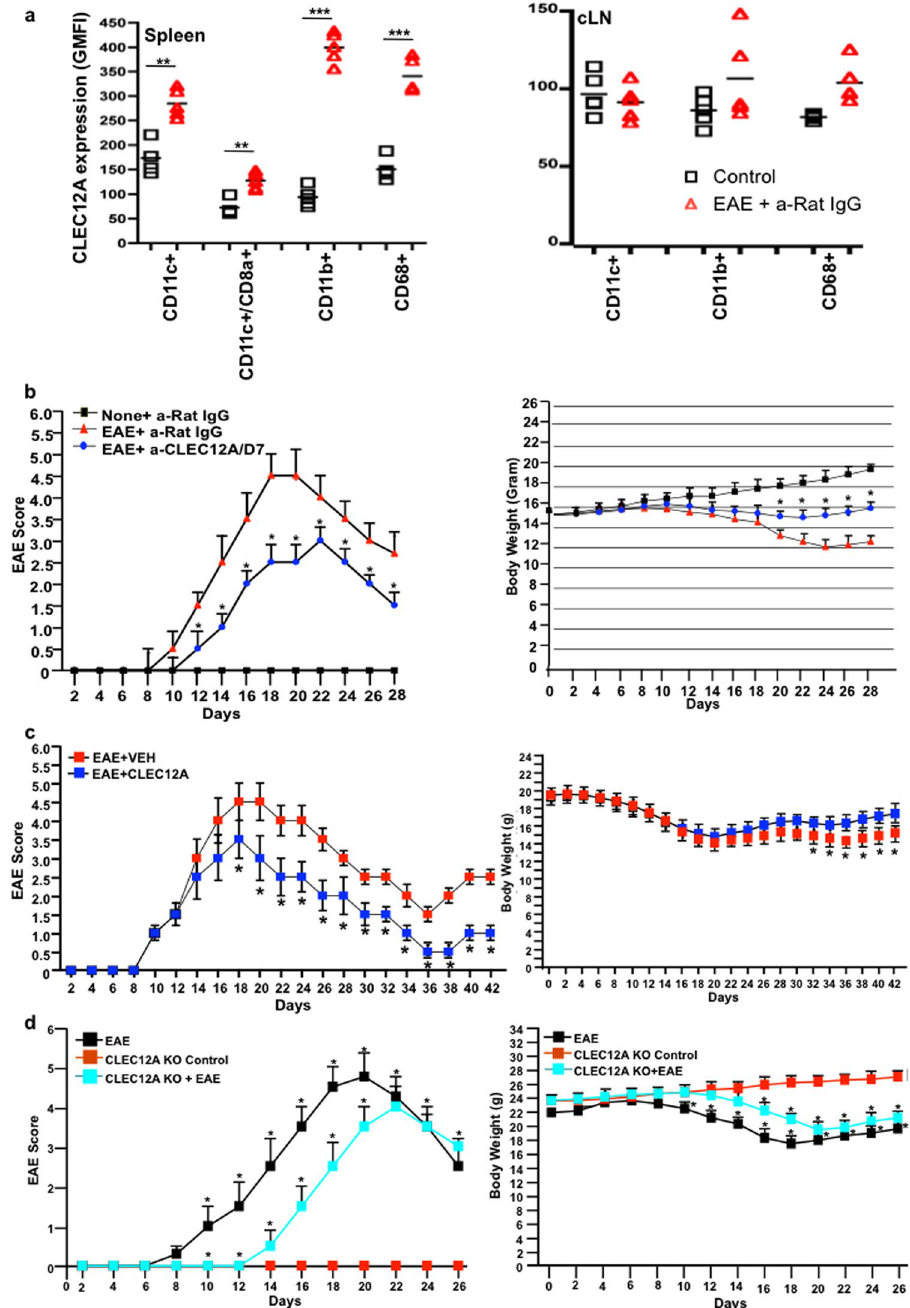
Figure 5. Impact of anti-CLEC12A antibody treatment on EAE severity and restoration in body weight. ( a ) Splenocytes and cLN cells from control and EAE mice were phenotyped for immune cell markers and further stained individually for CLEC12A expression. Plots represent CLEC12A GMFI levels of all animals in each group analyzed (n = 5) with the mean GMFI expression represented for each marker. ( b ) Data points indicating mean (n = 5) clinical disease score of C57BL/6 mice from control, EAE + IgG isotype and EAE + anti-CLEC12A antibody treatment on Day 7 (left panel). The body weight of control, EAE and Day 7 treated mice are shown on the right. ( c ) Data points indicating mean (n = 5) clinical disease score of SJL/J mice from EAE + vehicle and EAE + CLEC12A antibody treatment (Day 14 & Day 21) (left panel). The body weight of EAE and anti- CLEC12A antibody-treated mice are shown on the right. ( d ) Data points indicating mean (n = 5) clinical disease score (left) of C57BL/6 mice with EAE and C57BL/6 mice with/without CLEC12A and with/without EAE. The body weights of mice are shown on the right. * P < 0.01 and ** P <